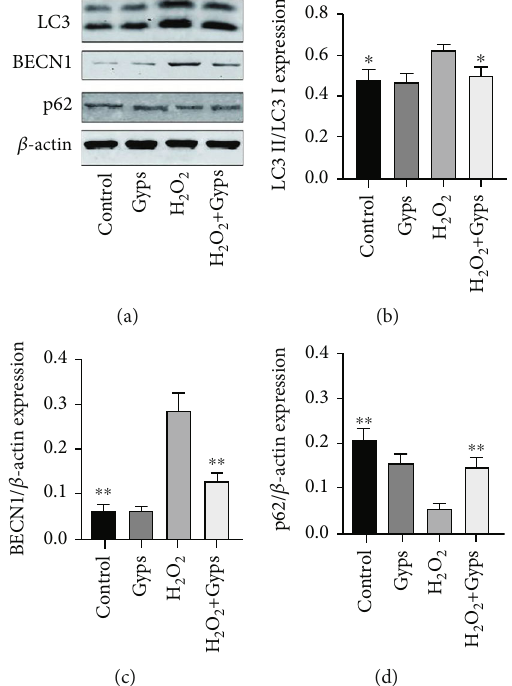
Figure 13: Gypenosides can reduce autophagy induced by H expression of LC3II and BECN1 increased, and the expression of p62 decreased after H intervention group, the expression of LC3II and BECN1 decreased, while p62 increased in preintervention of gypenosides was further increased. These bands are quanti fi ed by densitometry and then normalized to the level of β -actin in the same sample. (b) The value obtained by dividing the band density of the transcription factor of LC3 II by the band density of LC3 I. On the other hand, (c) and (d) are expressed by the ratio of band density to β -actin band density. Three samples from each of the three GO donors were taken for the experiment. All detections are repeated 3 times, with 3 replicate wells each time ( ∗ as P < 0 : 05 and ∗∗ as P < 0 : 01 ; P < 0 : 05 means the di ff erence is statistically signi fi cant, and P value is analyzed by one-way